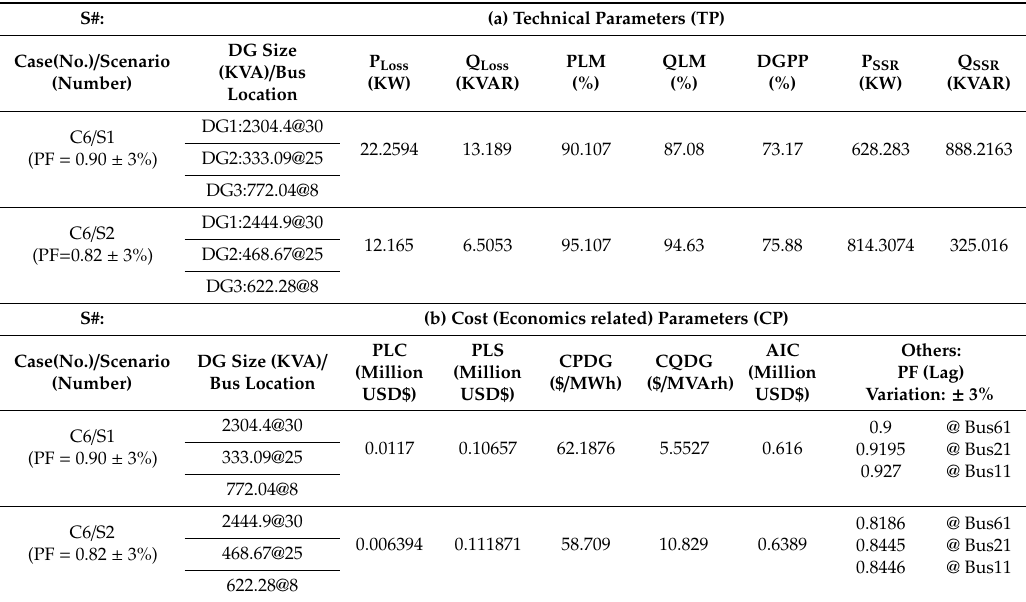
Table 10. (a) Overview of technical performance evaluation analysis in case 6 (69-bus TDS). (b) Overview of Cost-Economics performance evaluation analysis in case 6 (69-bus